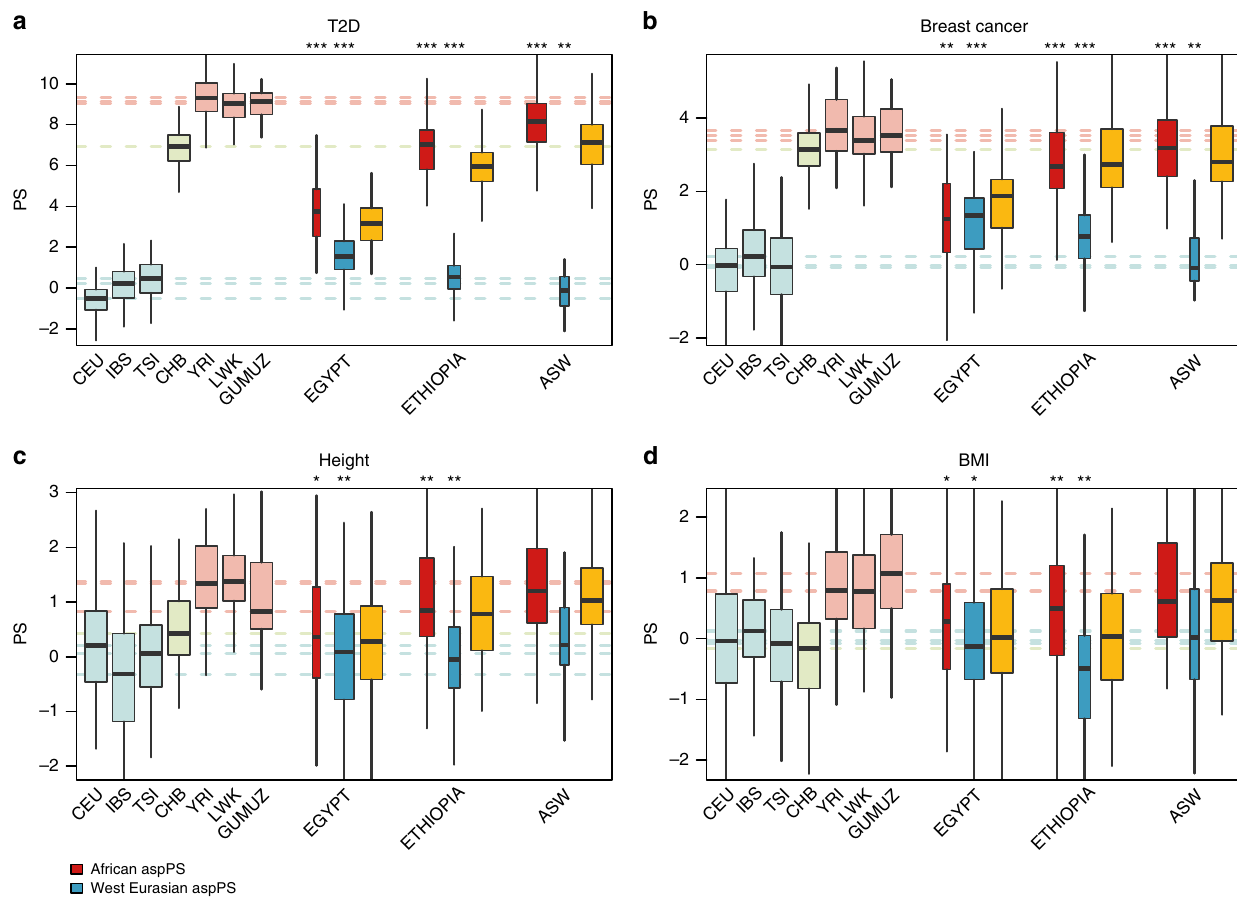
Fig. 2 Population-wide Polygenic Scores (PS) and ancestry speci fi c partial PS. PS distributions for seven reference populations (pastel colors), three admixed populations (yellow) and their relative ancestry speci fi c partial PS (red and blue). Reference population medians are represented with dashed lines. The width of the boxplots is proportional to the median size of the ancestry fraction used to compute each aspPS. Four different PS for different phenotypes are shown: ( a ) T2D 28 , ( b ) breast cancer 30 ( c ) height 29 , ( d ) BMI 29 . Signi fi cant differences with randomly assigned ancestral components are encoded as: *: p ≤ 0.05, **: p ≤ 0.005, ***: p ≤ 10 − 5 , (one-sided Wilcoxon signed-rank test). Sample sizes and exact P -values are reported in Supplementary Data 1. For each distribution, the box represent the interquartile range (IQR = Q 3 − Q 1 ), the line across the box indicate the median, the whiskers extend to the most extreme data points within Q 1 − 1.5IQR and Q 3 + 1.5IQR, outliers are omitted. CEU: North-West Europeans from Utah; IBS: Iberians from